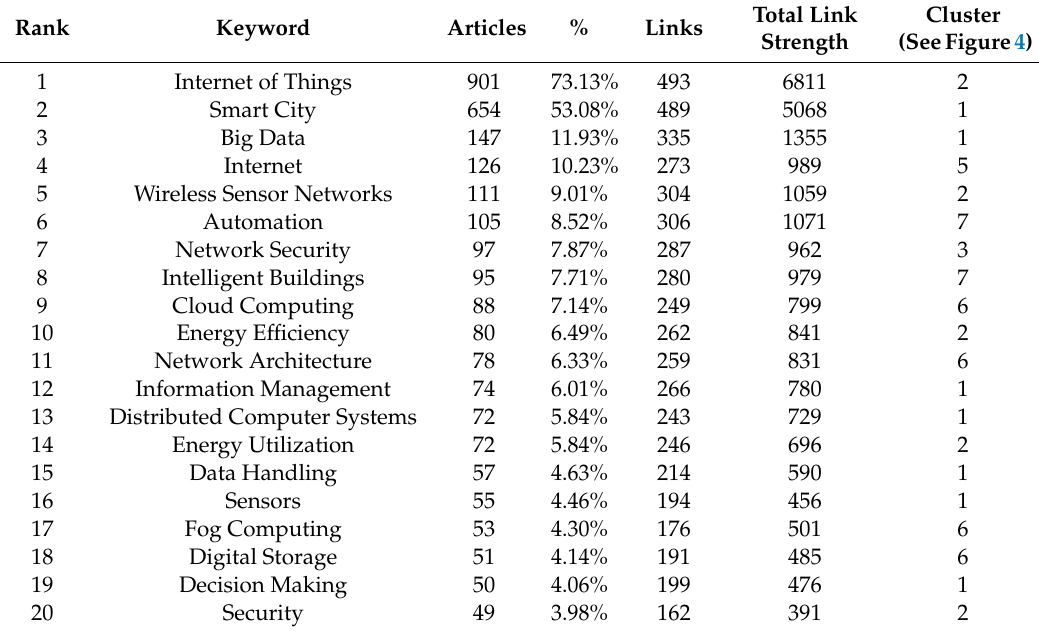
Table 3. Top 20 keywords